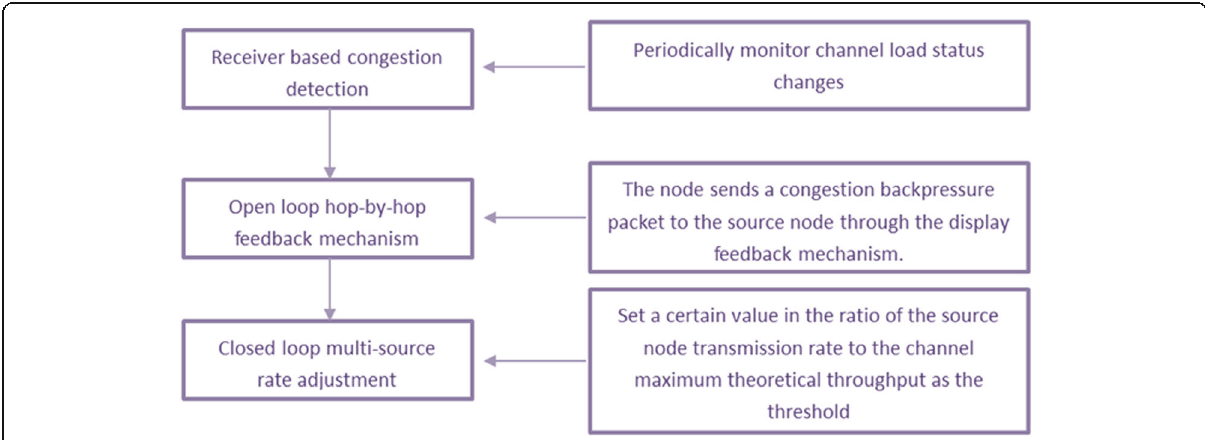
Fig. 1 Running Flow chart of the CODA